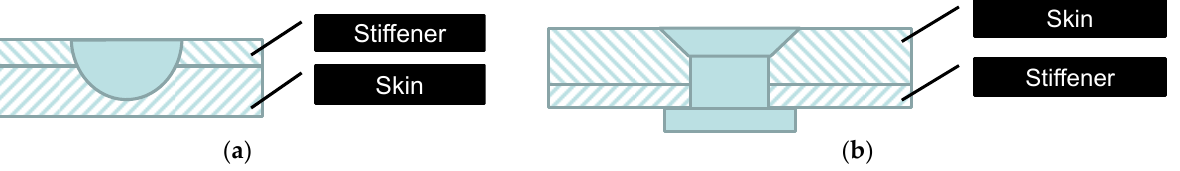
Figure 3. Lap joint configurations: ( a ) refill spot weld configuration and ( b ) rivet joint configuration.